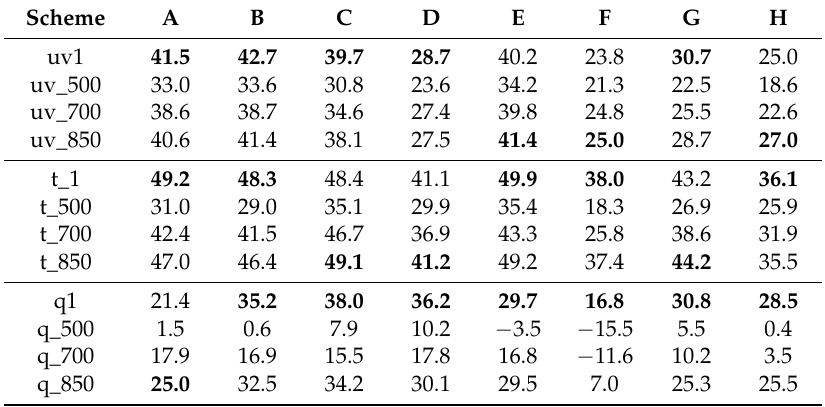
Table 5. Same as Table 4, but for the simulations at sounding standard